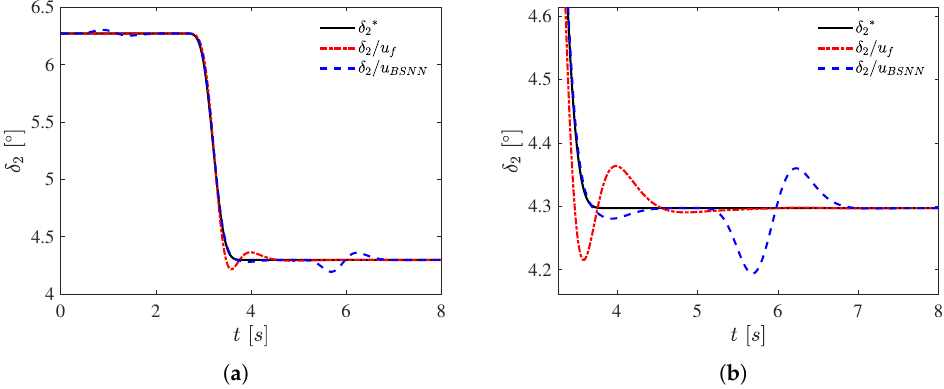
Figure 8. Load angle of generator 2 of two interconnected power systems: ( a ) δ 2 ; ( b ) zoom of δ 2